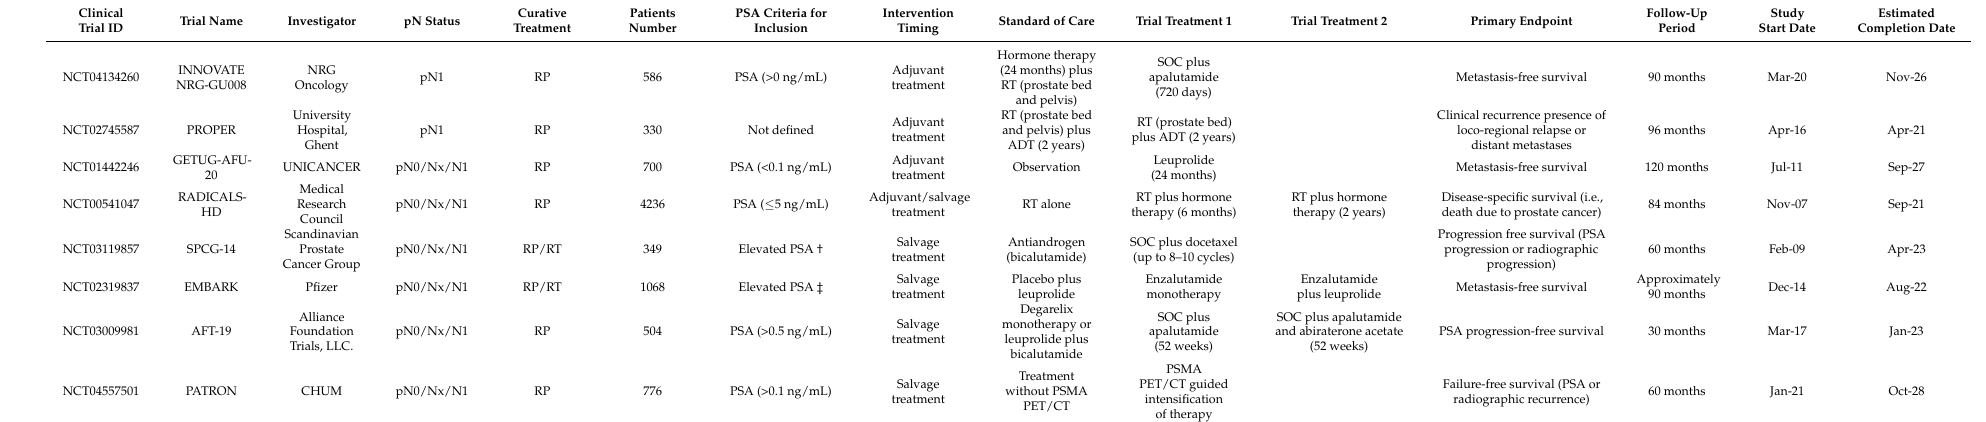
Table 4. Phase 3 randomized clinical trials under investigation for node-positive prostate cancer after